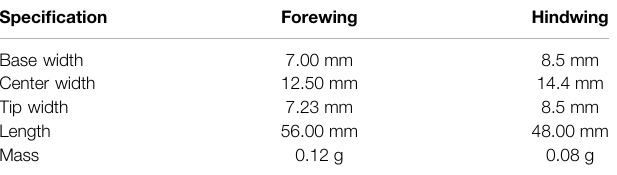
TABLE 1 | BMAV wing structure speci fi cation.